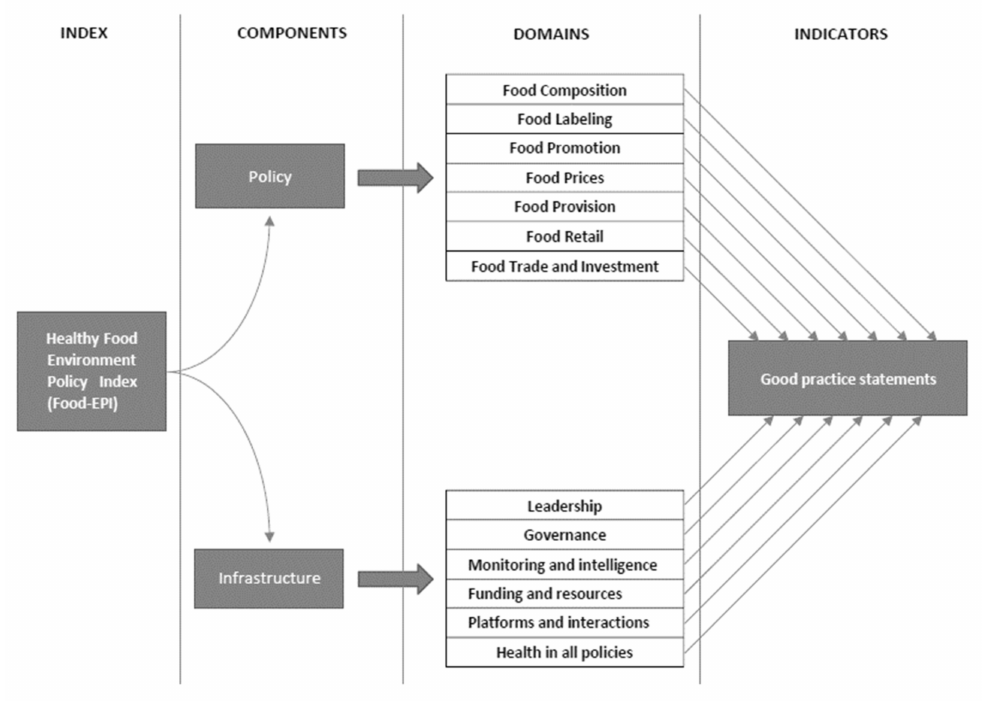
Figure 2. Healthy Food Environment Policy Index components, domains and